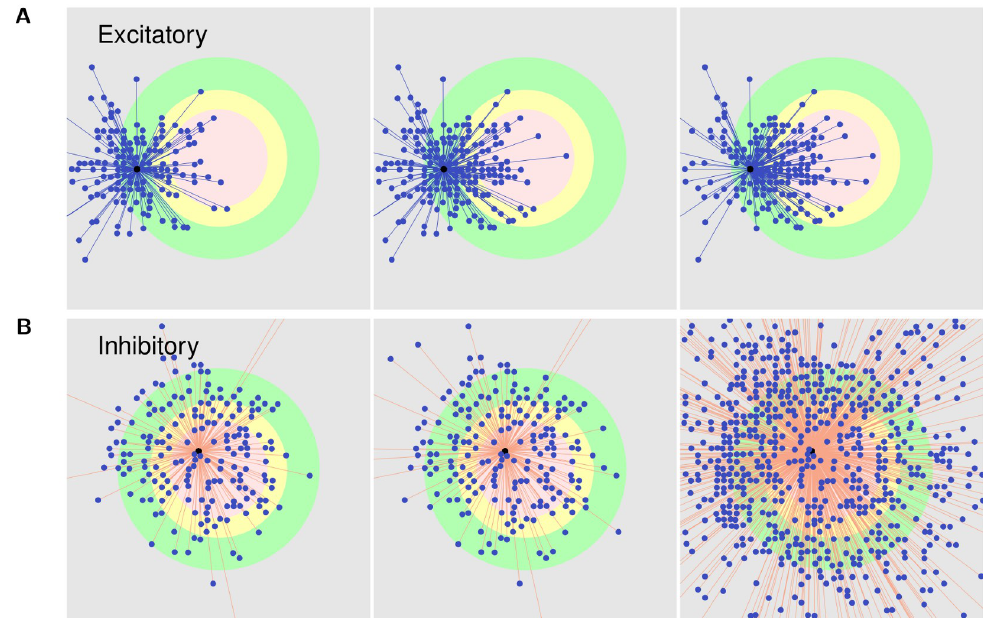
Fig 12. Outgoing projections. (A) shows the outgoing (axonal) projections of an excitatory neuron in the peri-LPZ. (B) shows the outgoing (axonal) projections of an inhibitory neuron in the LPZ C. From left to right: t = 2000 s, t = 4000 s, and t = 18,000 s. As per our suggested growth rules for pre-synaptic elements, excitatory neurons produce new pre-synaptic elements and sprout axonal projections when they experience extra activity, while inhibitory neurons form new pre- synaptic elements and grow axons when they are deprived of activity. As a consequence and in line with experimental data, following deafferentation of the LPZ, excitatory neurons in the peri-LPZ sprout new outgoing projections that help transfer excitatory activity to neurons in the LPZ. Also in accordance with experimental work, inhibitory neurons inside the LPZ form new outgoing connections that transmit inhibition to neurons outside the